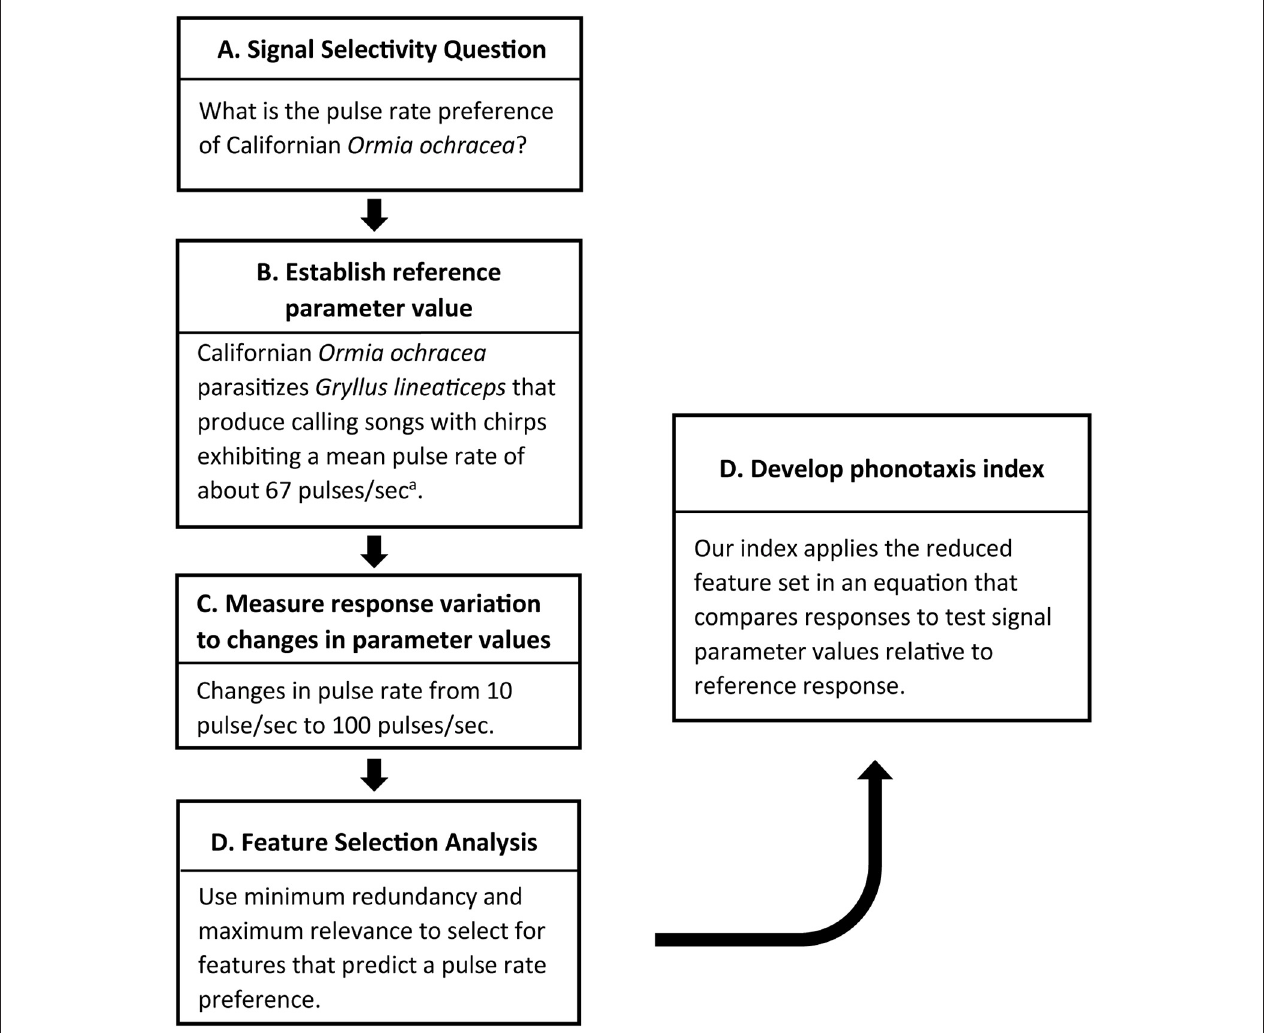
FIGURE 7 | Approach for developing a phonotaxis performance index. Developing a phonotaxis performance index to address a specific question (A) with some knowledge of salient signal values of a particular signal feature (B) to serve as a reference for comparison. (C) Behavioral responses are measured in response to varying signal values. This is followed by a feature selection approach to narrow down the list of response features that predict natural signal preferences. (D) These response features are incorporated into a performance index that compares responses to test signals relative to a reference response. a Mean pulse rate reported in Wagner and Reiser (2000). Measures of variance not